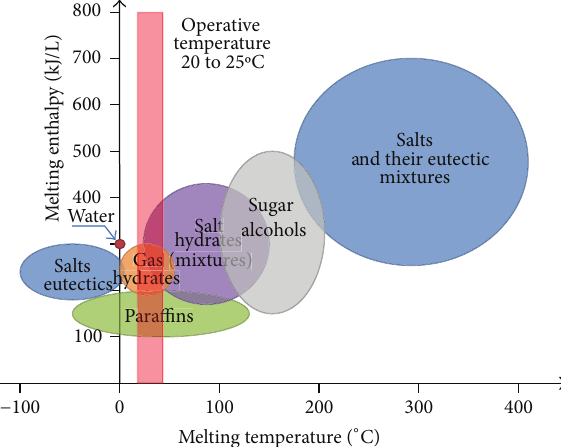
Figure 1: Melting temperatures and phase change enthalpy for existing PCMs (adapted from